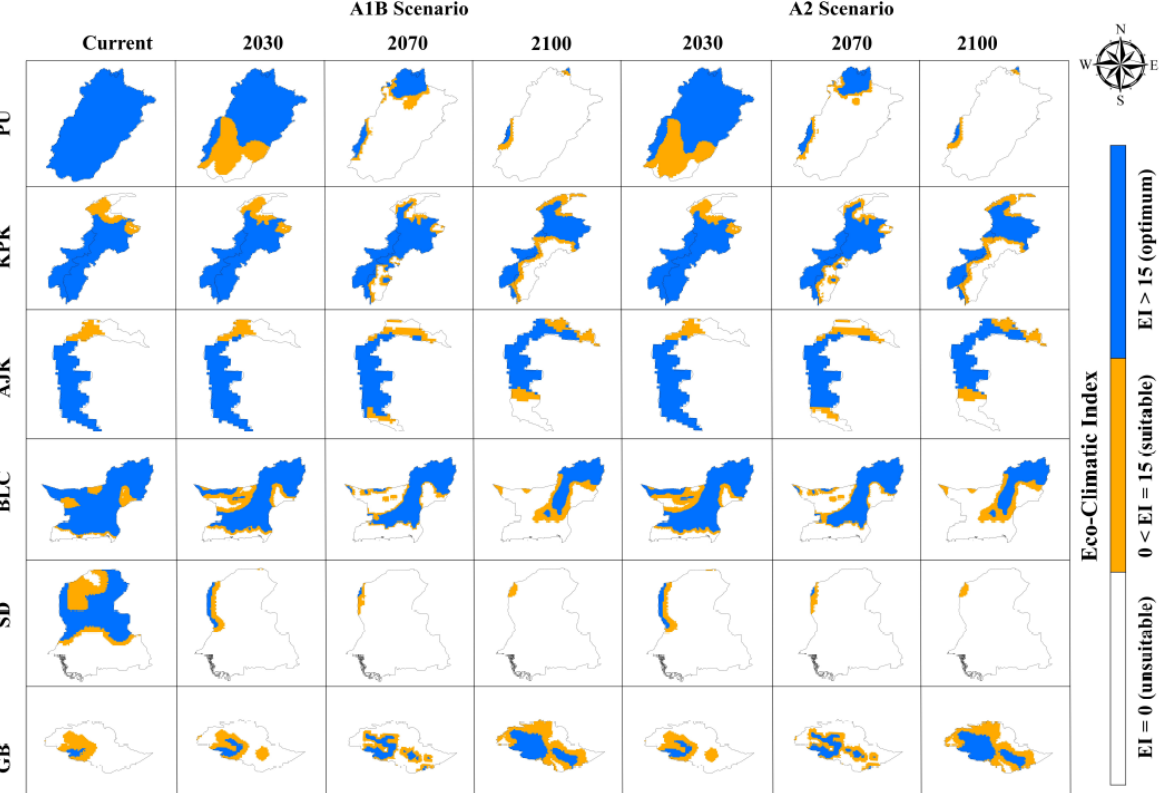
Figure 5. Predicted administrative area-wise potential distribution of Aelosthes sarta in Pakistan under historic and future climatic conditions in the time periods of 2030, 2070, and 2100 under A1B and A2 scenarios. Predicted regional distributions (three colors) narrate the ecoclimatic index (EI) from the CLIMEX model: blue = optimum habitat (EI >15); orange = suitable habitat (0< EI = 15); white = unsuitable habitat (EI = 0). PB = Punjab; KPK = Khyber Pakhtunkhwa; AJK = Azad Jammu and Kashmir; BLC = Balochistan; SD = Sindh; GB = Gilgit Baltistan.